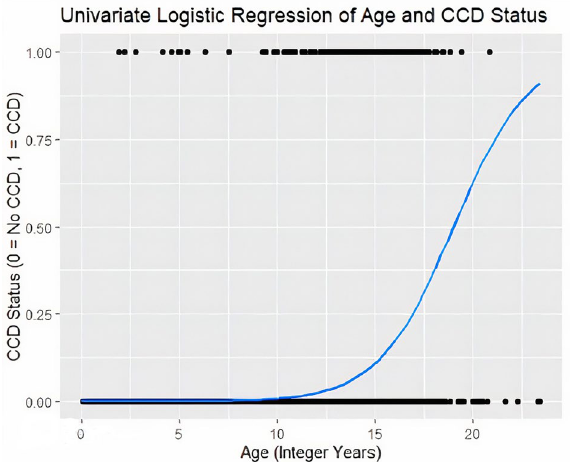
Figure 1. Logistic Regression curve representing association between age and CCD status, Dog Aging Project, 2020–2021.